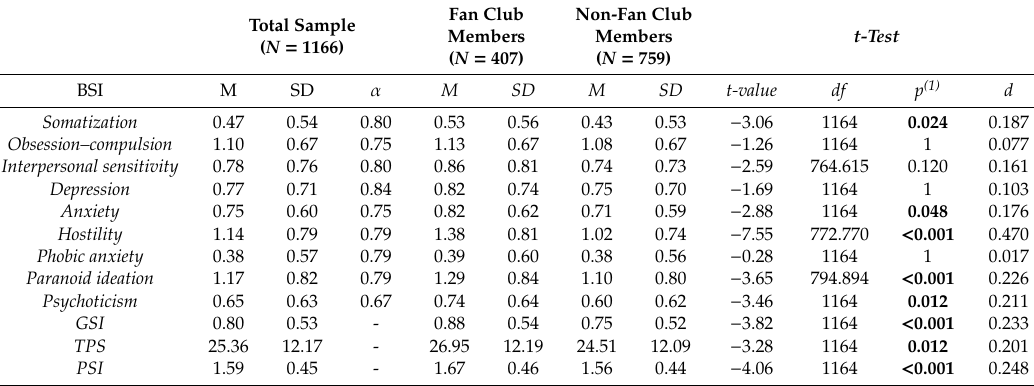
Table 3. Descriptive statistics, Cronbach’s alpha ( α ) and t -tests results with Bonferroni correction of BSI dimensions and